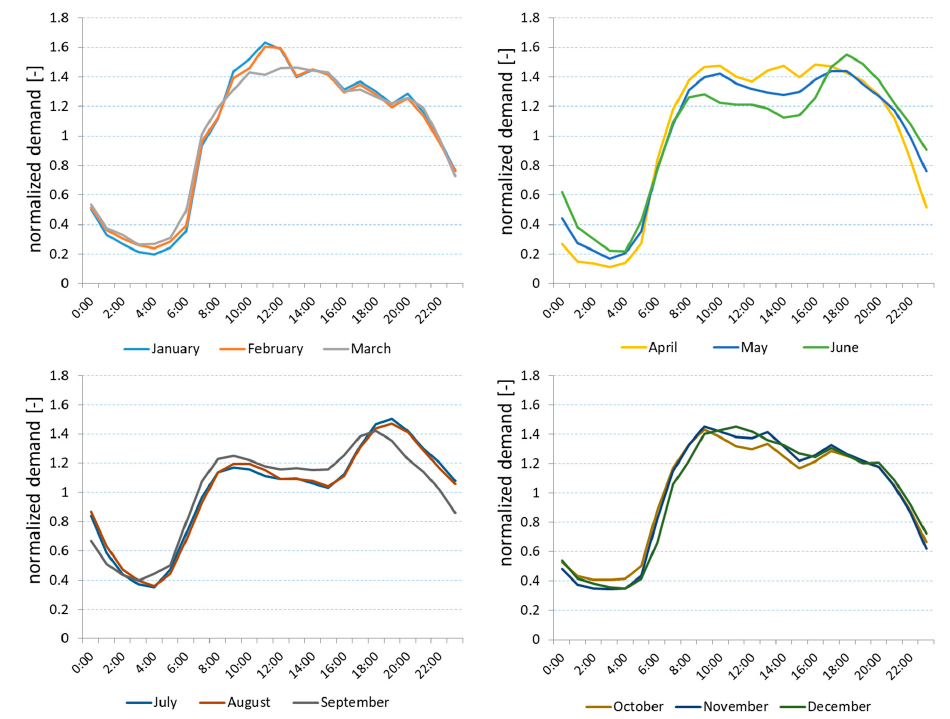
Figure 8. Normalized hourly demand profiles for every month after the leakage is estimated (with a bottom up approach) and subtracted by the SIV.